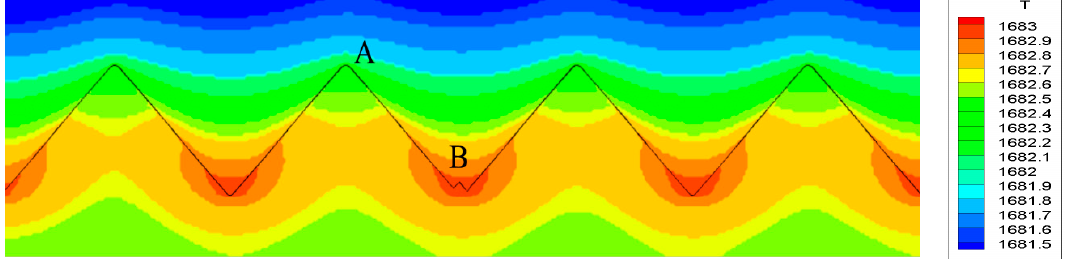
Figure 6. Three-dimensional facet temperature field and solid phase ratio profile.